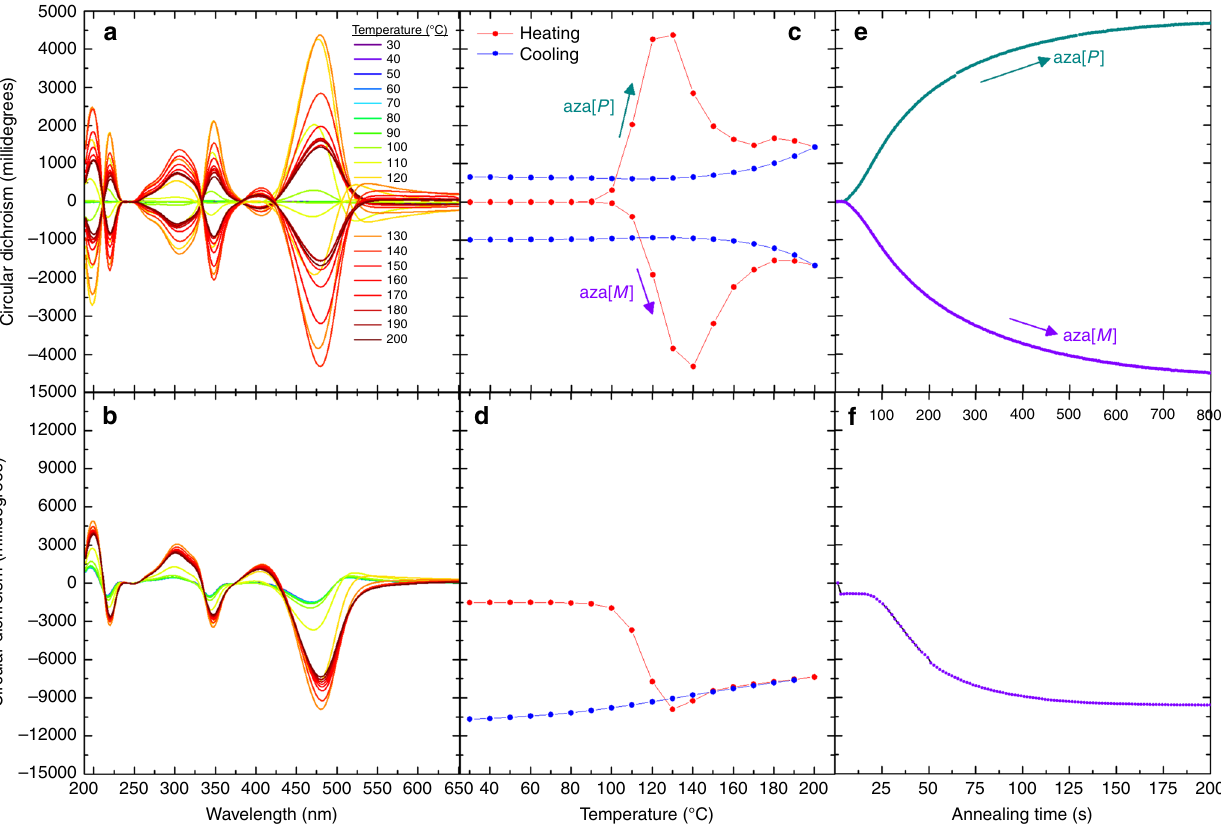
Fig. 7 In situ chiroptical response of ACPCA and CSCP thin fi lms. In situ CD spectra recorded during heating and cooling of ( a ) ACPCA (F8BT: aza[6]H) and ( b ) CSCP (cPFBT) thin fi lms (note blue represents low temperatures and red represents high temperatures), ( c ) and ( d ) the CD intensity recorded at 480 nm as a function of temperature during heating (red) and cooling (blue), and ( e ) and ( f ) CD intensity of thin fi lms held at 140 °C as a function of time for [ P ] (turquoise) and [ M ] (purple) systems (note the different time on-axis).